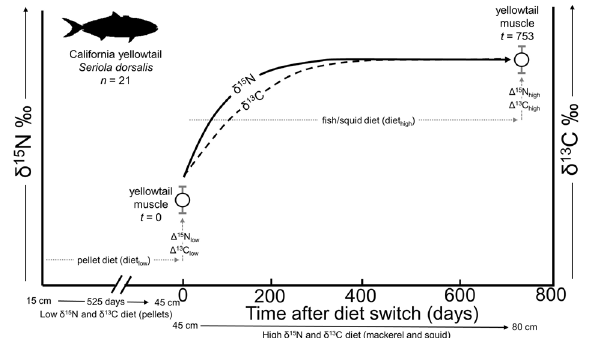
Figure 1. Schematic showing experimental design to quantify dynamics of δ 15 N and δ 13 C in captive California yellowtail Seriola dorsalis . Sizes (cm) below x-axis show approximate changes in yellowtail fork length during the phases of the experiment. Lines showing changes in yellowtail muscle δ 15 N (solid line) and δ 13 C (dashed line) are theoretical changes based on typical isotopic turnover dynamics in